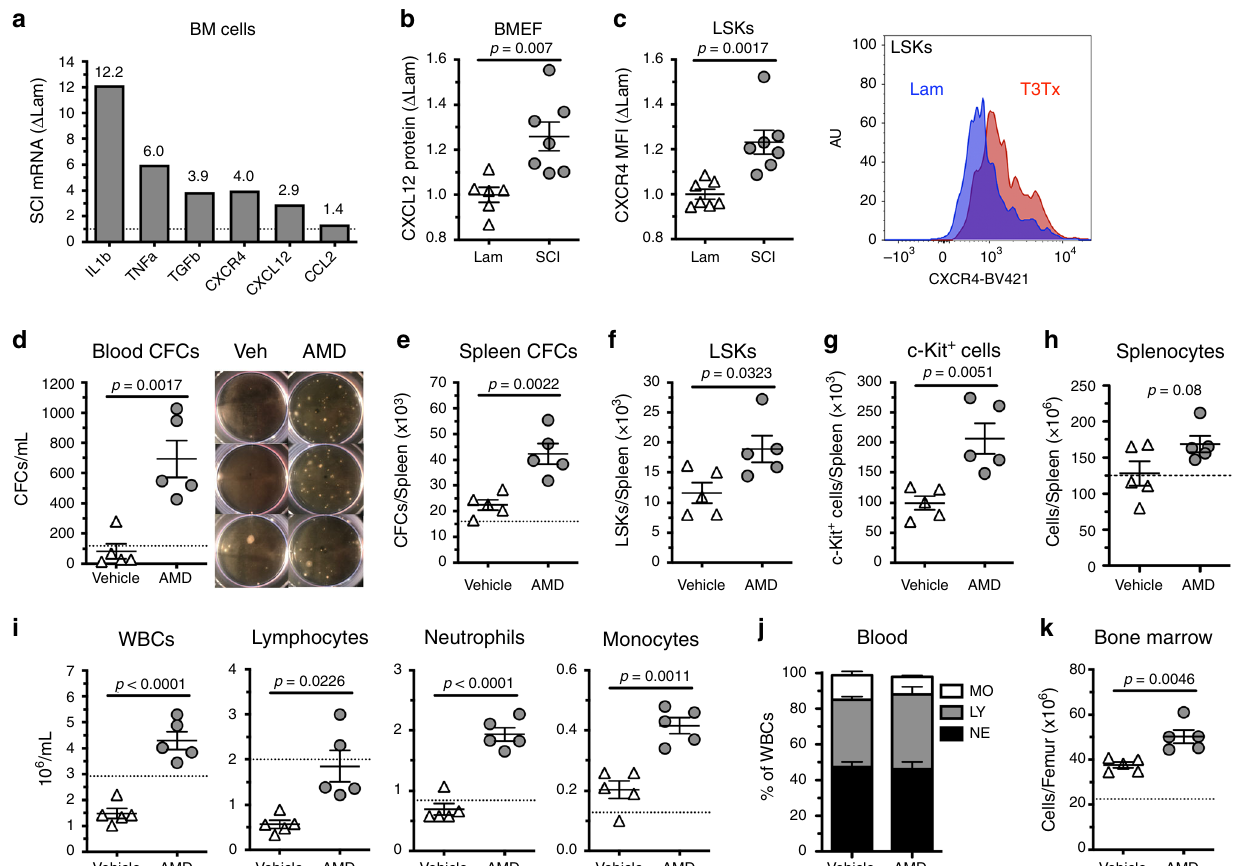
Fig. 6 Plerixafor (AMD3100) mobilizes HSPCs, rescues extramedullary hematopoiesis, and boosts circulating immune cells after T3 transection SCI. a Cytokine and chemokine mRNA expression from whole-bone marrow cells of SCI mice 3 dpi (expressed as fold change of Lam). b CXCL12 protein expression from bone marrow extracellular fl uid extracts. c Protein expression (MFI) of CXCR4 expression on LSKs from whole bone marrow. d Total CFCs per mL whole blood, e CFCs per spleen, f LSKs per spleen, g c-Kit + HSPCs per spleen, and h total cells per spleen 3 days after SCI with and without daily AMD3100 treatment (once per day). i Total white blood cells (WBCs), lymphocytes, neutrophils, and monocytes per mL whole blood. j Proportion of monocytes (MO), lymphocytes (LY), and neutrophils (NE) in whole blood ( n = 5/group). k Total cells per femur. All data are mean ± SEM, two-sample t -test; n = 3/group (pooled) in a ; n = 6 and 7/group in b ; n = 7/group in c ; n = 5/group in d – k . Dotted lines represent average data from lam ( a ) or naïve mice ( d , e , h, i, k ). BM bone marrow, MFI mean fl uorescence intensity, WBCs white blood cells, MO monocytes, LY lymphocytes, NE neutrophils, AMD Plerixafor (AMD3100). Source data are provided as a Source Data fi